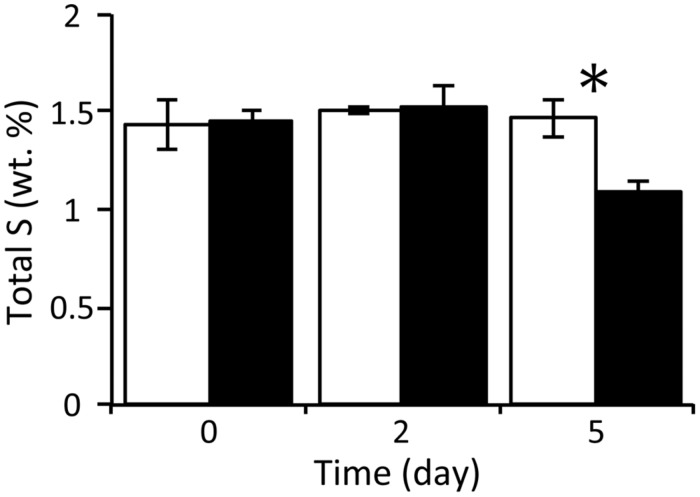
Changes in the content ratios of sulfur elements in the solid-phase sediments during anoxic incubation of nitrate-amended marine sediments (black bar) and the control (white bar). The error bars indicate the standard deviations of three replications. Asterisks indicate significant differences in content ratios between the two treatments (∗p < 0.05).